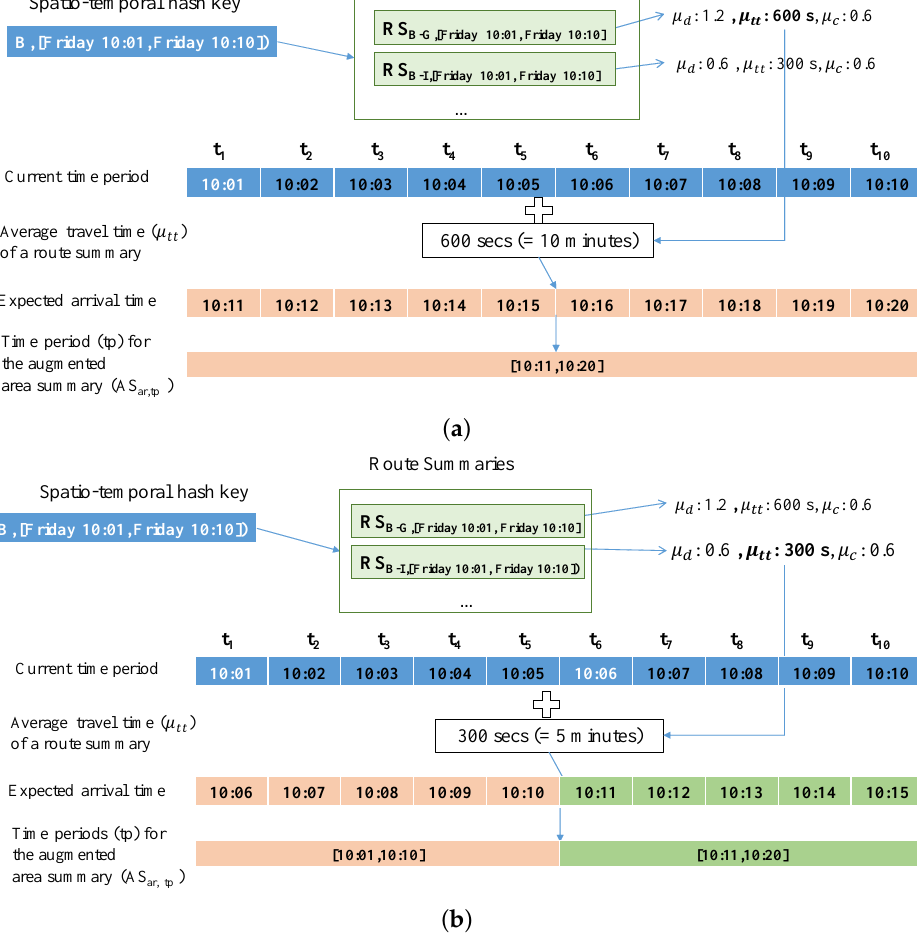
Figure 11. Arrival time mapping. ( a ) a non-split case; ( b ) a split